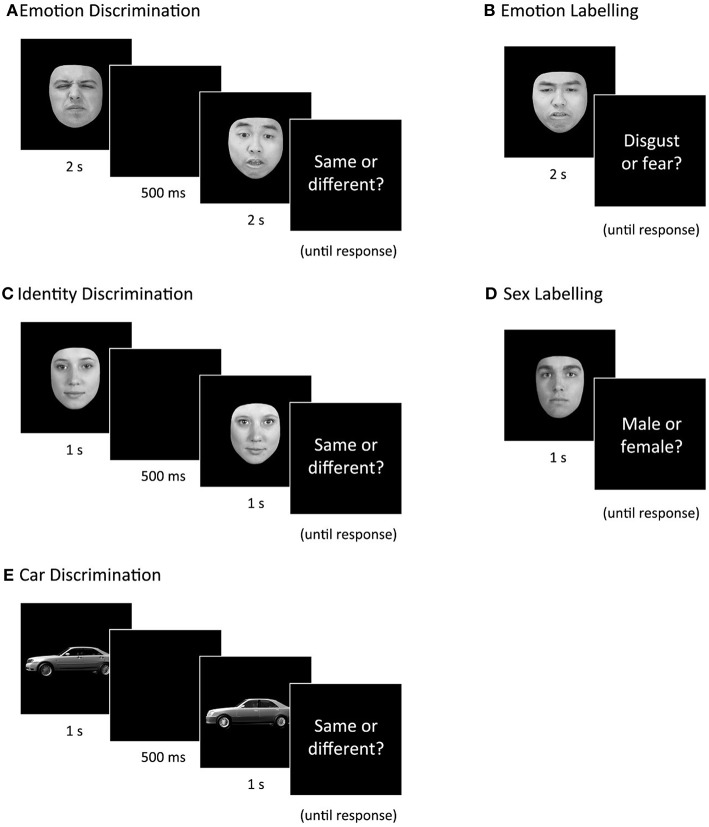
Example trials for each of the five tasks: Emotion Discrimination, Emotion Labeling, Identity Discrimination, Sex Labeling, and Car Discrimination. Correct responses are (A) different, (B) disgust, (C) different, (D) male, (E) different.